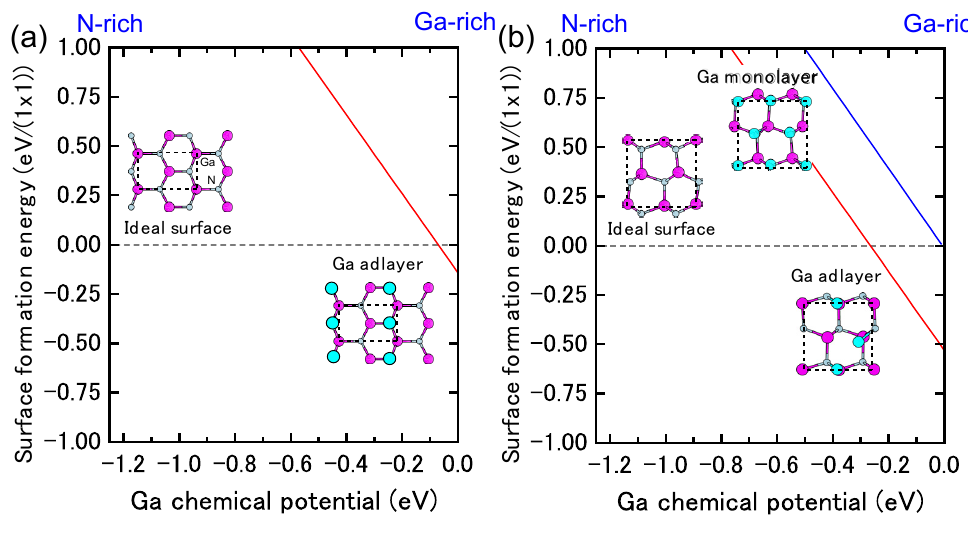
Figure 12. Calculated surface formation energies of nonpolar GaN surfaces with _ _ 00) and ( b ) (112 0) orientations as a function of Ga chemical potential. Schematics ( a ) (11 of the surface structures under consideration are also